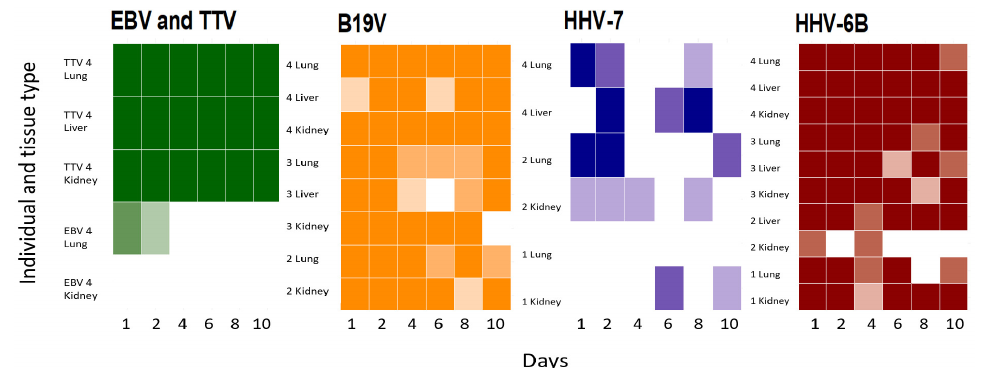
Figure 4. Virus DNA detection in FF and FFPE samples by qPCR. Each heat map represents the agreement of qPCR findings in the tissues of the four individuals ( y -axis) along fixation times ( x -axis) for the FF and FFPE samples. In dark = both FF and FFPE positive, medium = FFPE positive, light = FF positive, white = both FF and FFPE negative. From left to right and represented in colors, are EBV and TTV (green), B19V (orange), HHV-7 (purple), and HHV-6 (red).